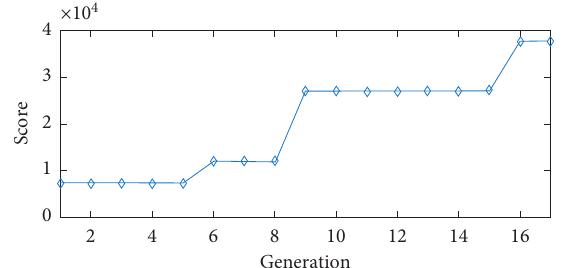
Figure 7: The GA performance for the active back case. The resulting trajectories are shown in Figure 6.